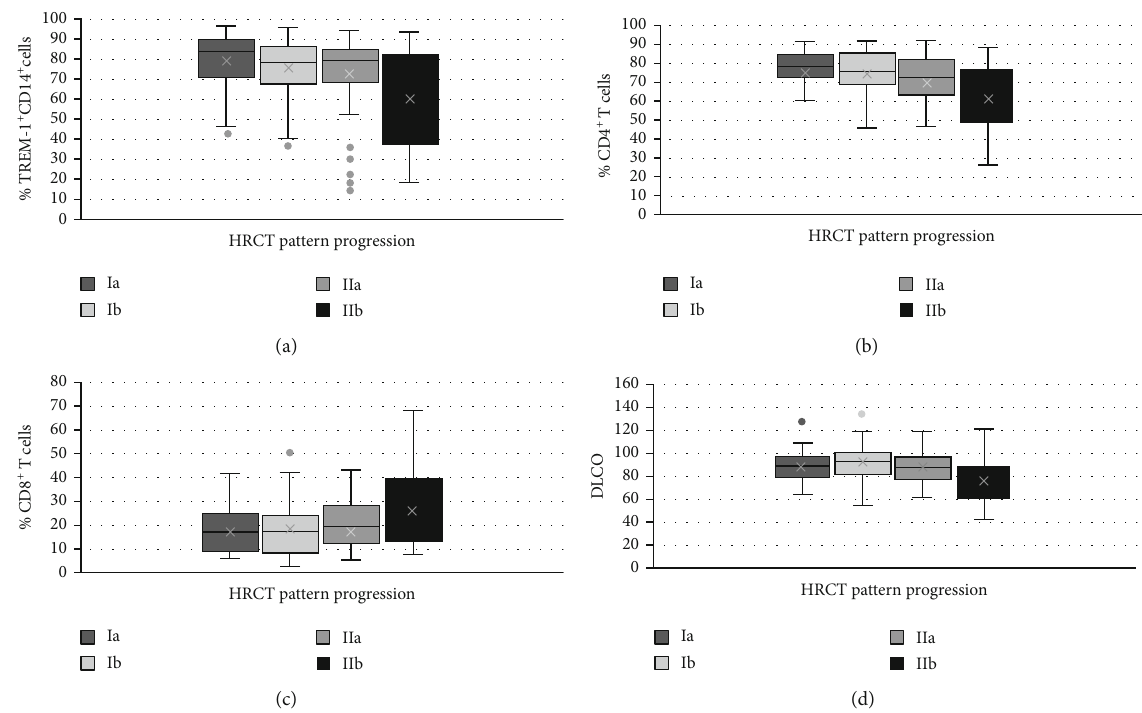
Figure 2: (a) Decrease in percentage of TREM-1 + CD14 + cells. (b) Decrease in percentage of CD4 + T cells. (c) Increase in percentage of CD8 + T cells. (d) Decrease in di ff using capacity of lungs for carbon monoxide (DLCO) in relationship with HRCT changes acquired from type Ia to type IIb. Ia-hilar and mediastinal lymphadenopathy with no pulmonary in fi ltrates; Ib-hilar and mediastinal lymphadenopathy and solitary nodules; IIa-hilar and mediastinal lymfadenopathy and numerous small pulmonary nodules building clusters in typical areas for sarcoidosis; IIb-hilar and mediastinal lymphadenopathy and pulmonary in fi ltrates or ground glass opacity.